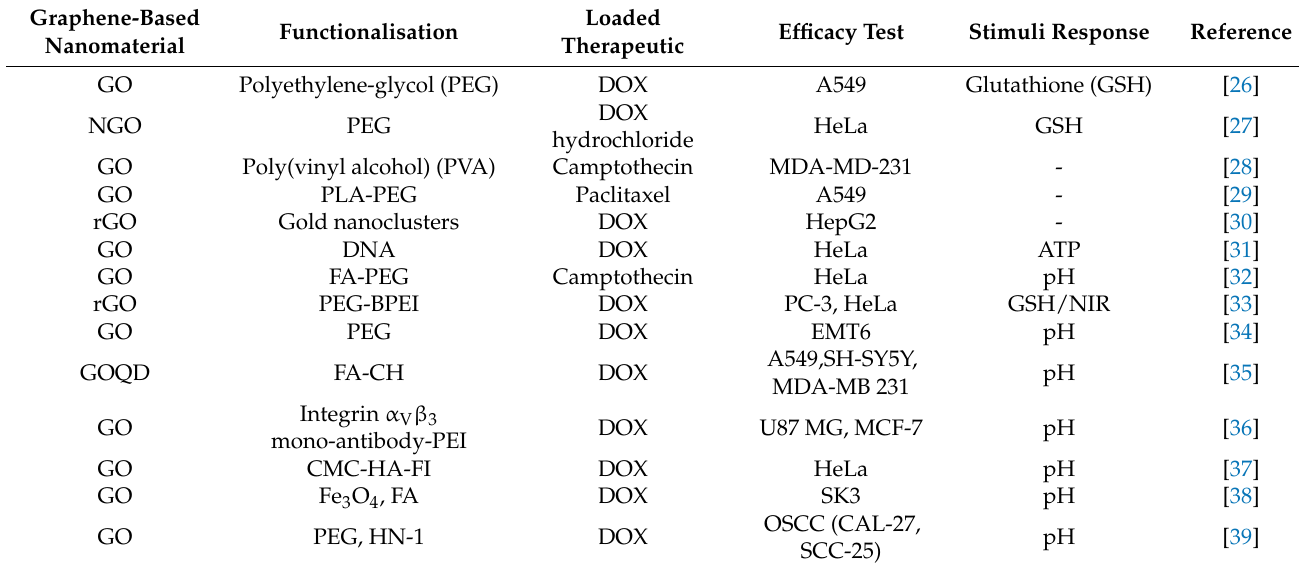
Table 1. Graphene-based nanocarriers developed for drug delivery applications. Further examples have been discussed elsewhere